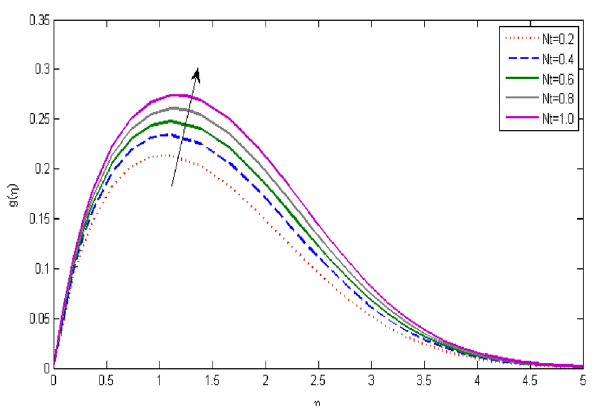
Figure 9. influence on g .